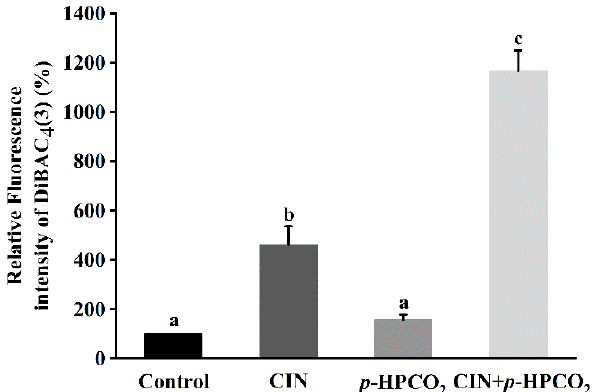
Figure 6. Relative fluorescence intensity of DiBAC 4 (3) in Saccharomyces cerevisiae after individual and combined treatments with cinnamon oil (CIN) (0.02%) and petit -high pressure CO 2 ( p -HPCO 2 ) (1.3 MPa) for 2 h at 25 °C. Different letters above bars indicate significant differences ( p < 0.05).